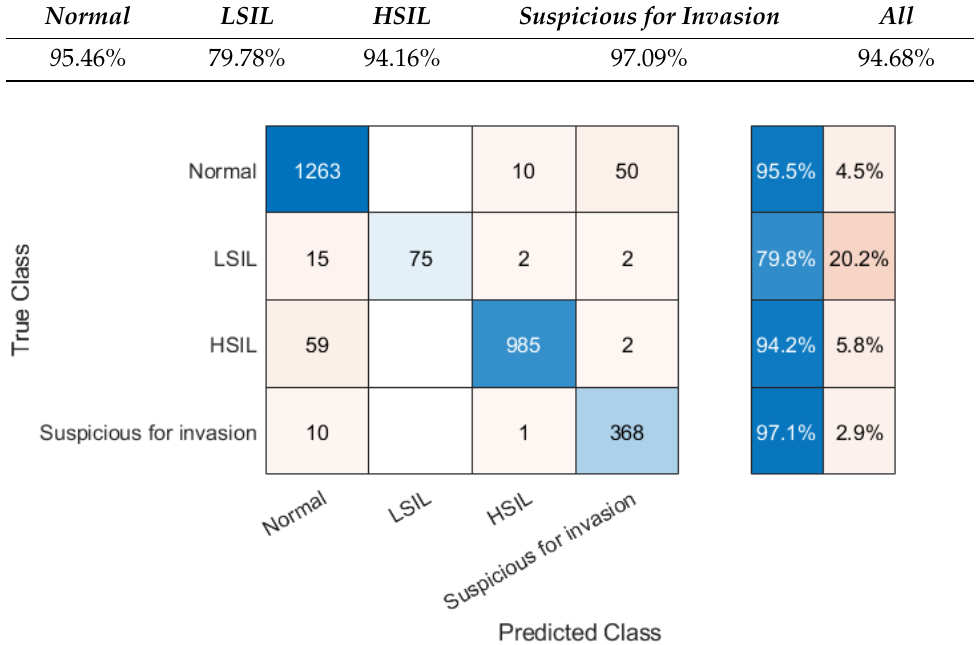
Table 2. Accuracy on the test dataset.